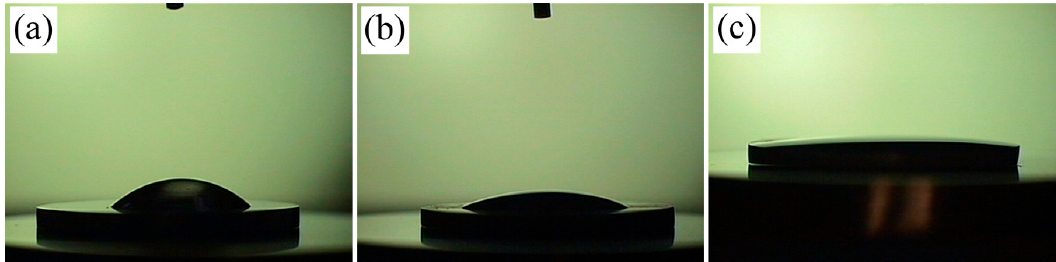
Figure 7. Representative contact angle images of ( a ) POL-; ( b ) MAO-; ( c ) MAO/HT-treated cp-Ti. Table 3. Contact angles of POL-, MAO-, and MAO/HT-treated sample surfaces ( n = 3). Contact Angle (degree) Samples POL (SD) MAO (SD) MAO/HT (SD)